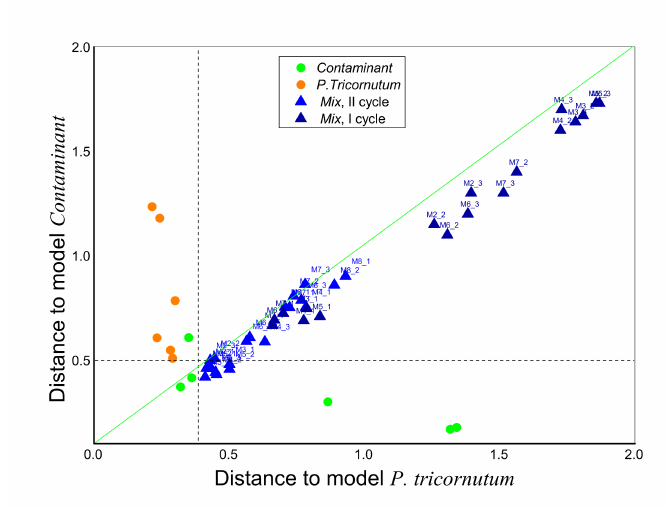
Figure 6. SIMCA classification Coomans plot for the Mix co-culture over the growth time in relation to the unialgal P. tricornutum and Contaminant cultures.